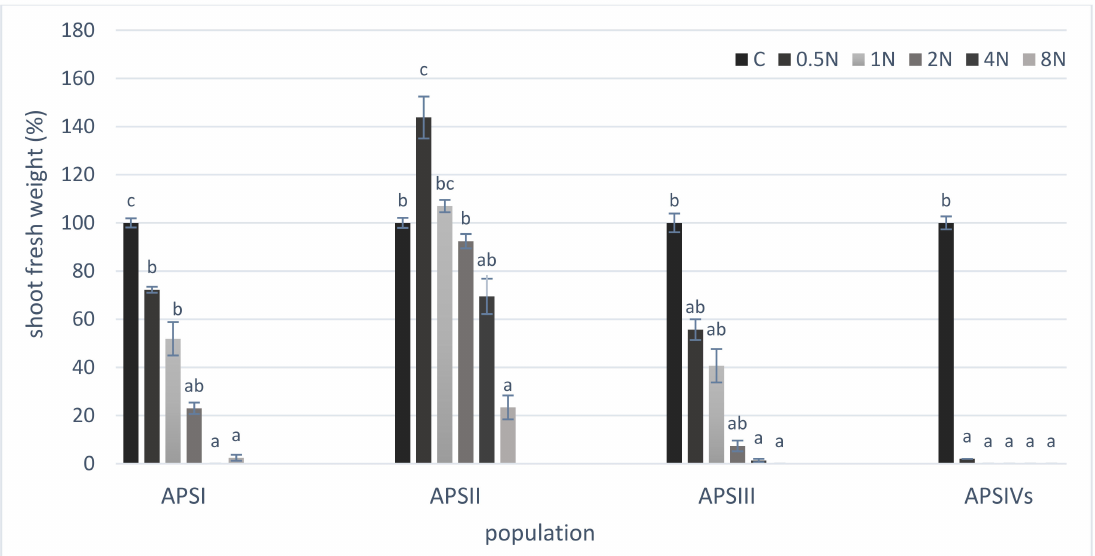
Figure 7. Shoot fresh weight of treated and untreated pinoxaden plants of A. spica-venti , expressed as a percentage of the control. The statistical analysis of the significance of differences was performed using the Tukey test for each population separately. Data are means ± SE, n = 3. Means marked by the same letter do not differ significantly. C: untreated control.